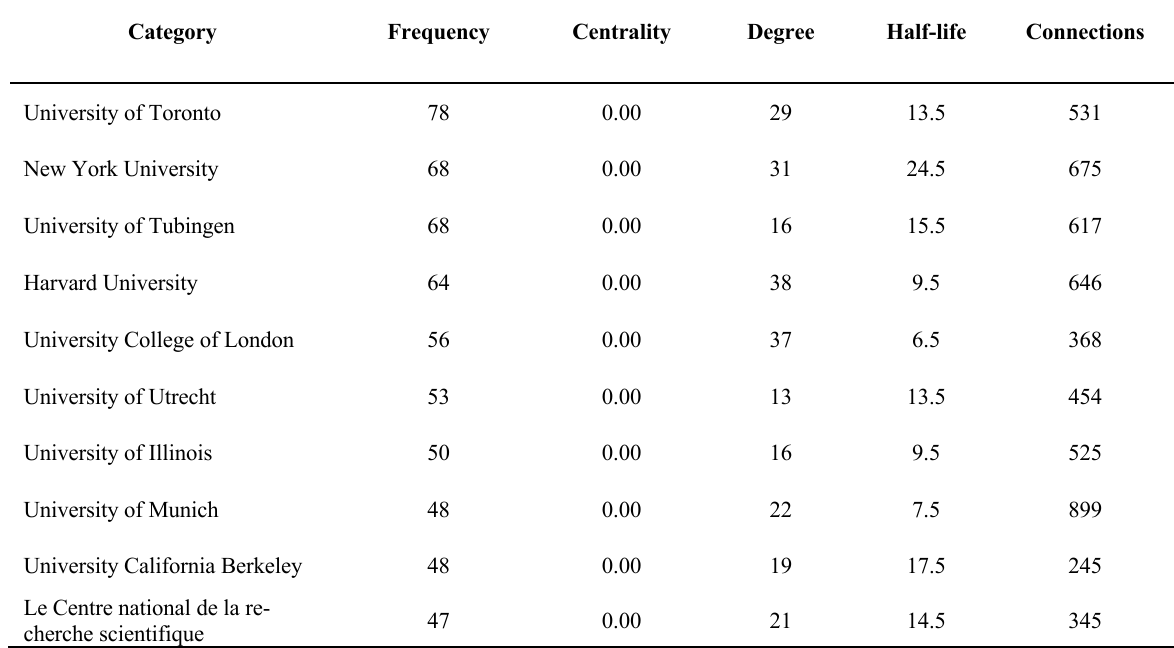
Table 4. Top 10 institutions with the highest number of publications